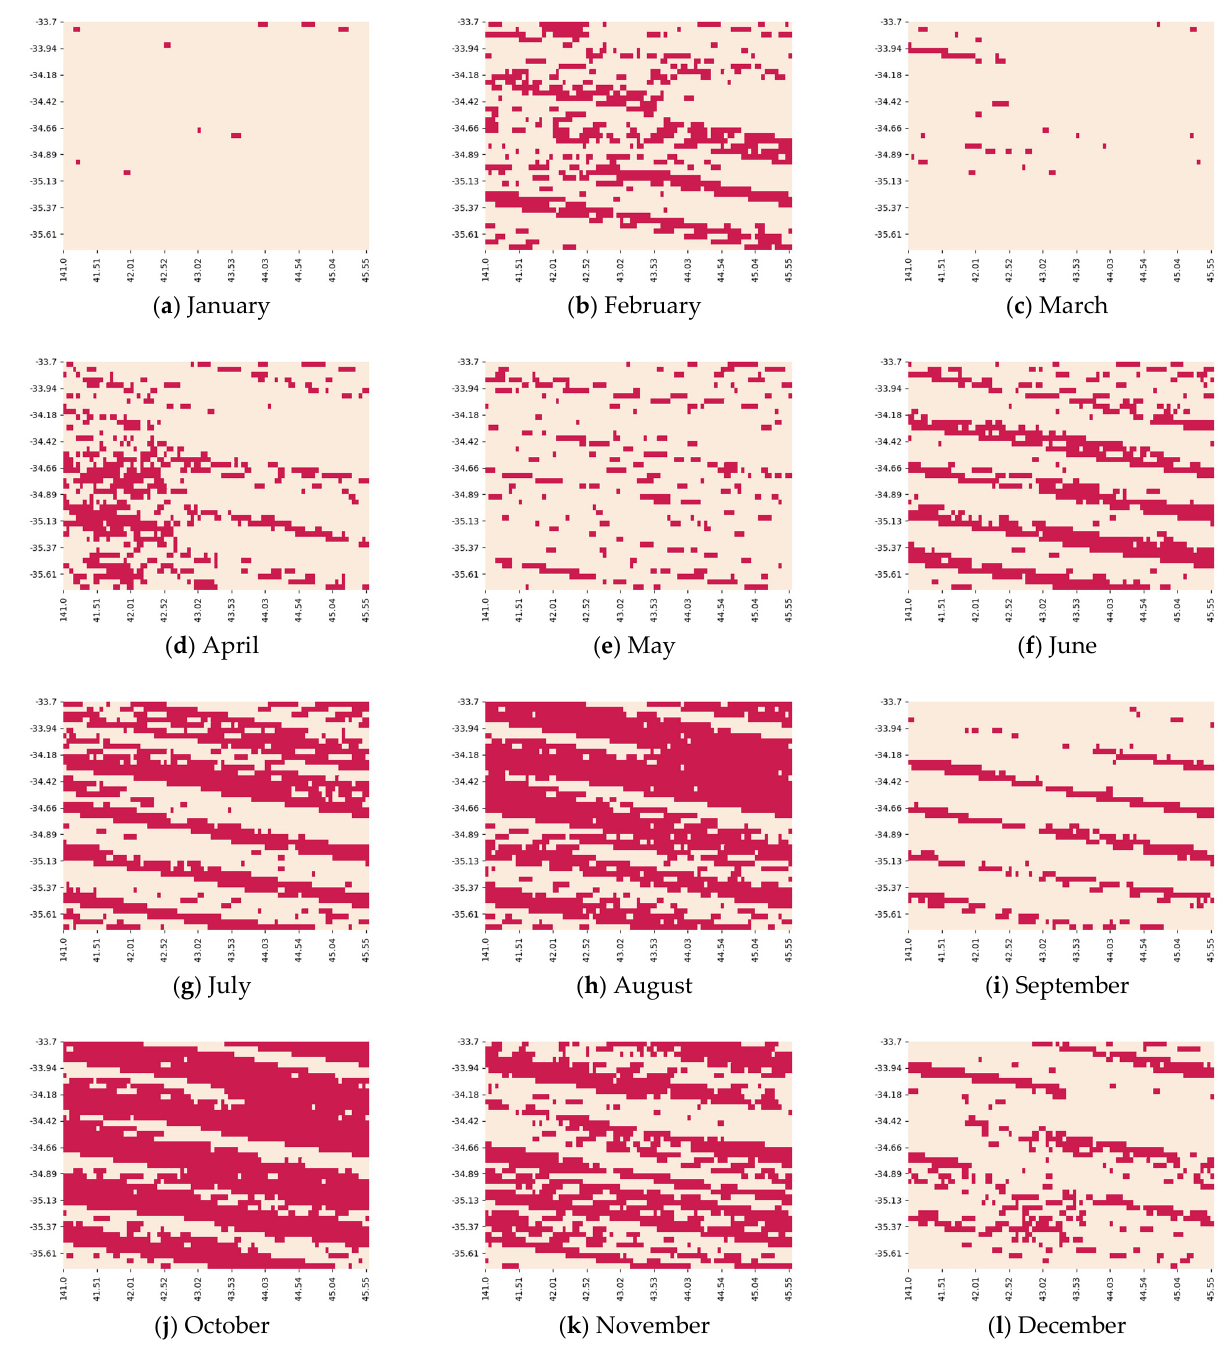
Figure A3. Heatmaps of the geolocated grids for Grassland Region of Australia in 2016 for 12 months. Cream colour denotes the grids which are not classified correctly. Red colour indicates the grids which are classified correctly. Figures ( a )–( l ) represent the heat map for 12 different months, respectively.